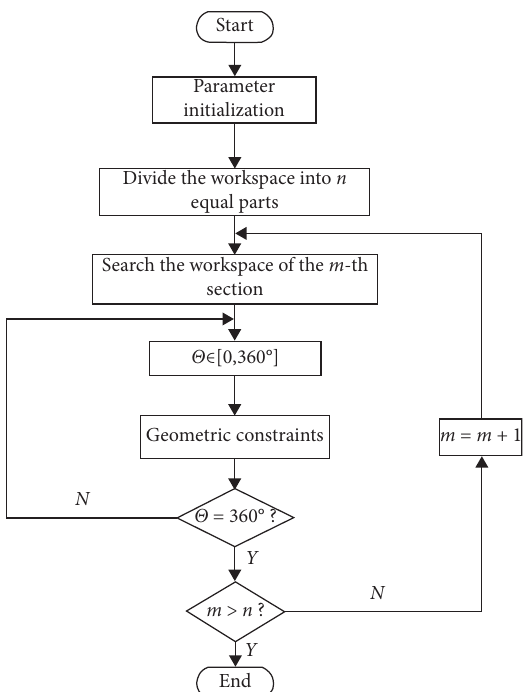
Figure 4: Flow chart of the